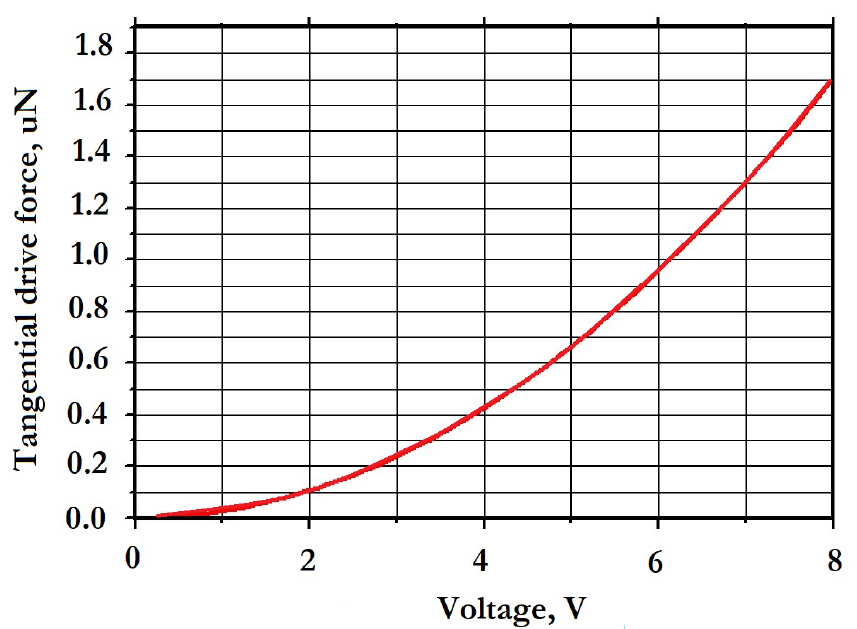
Figure 9. Graph of the dependence of the electrostatic drive force on voltage.